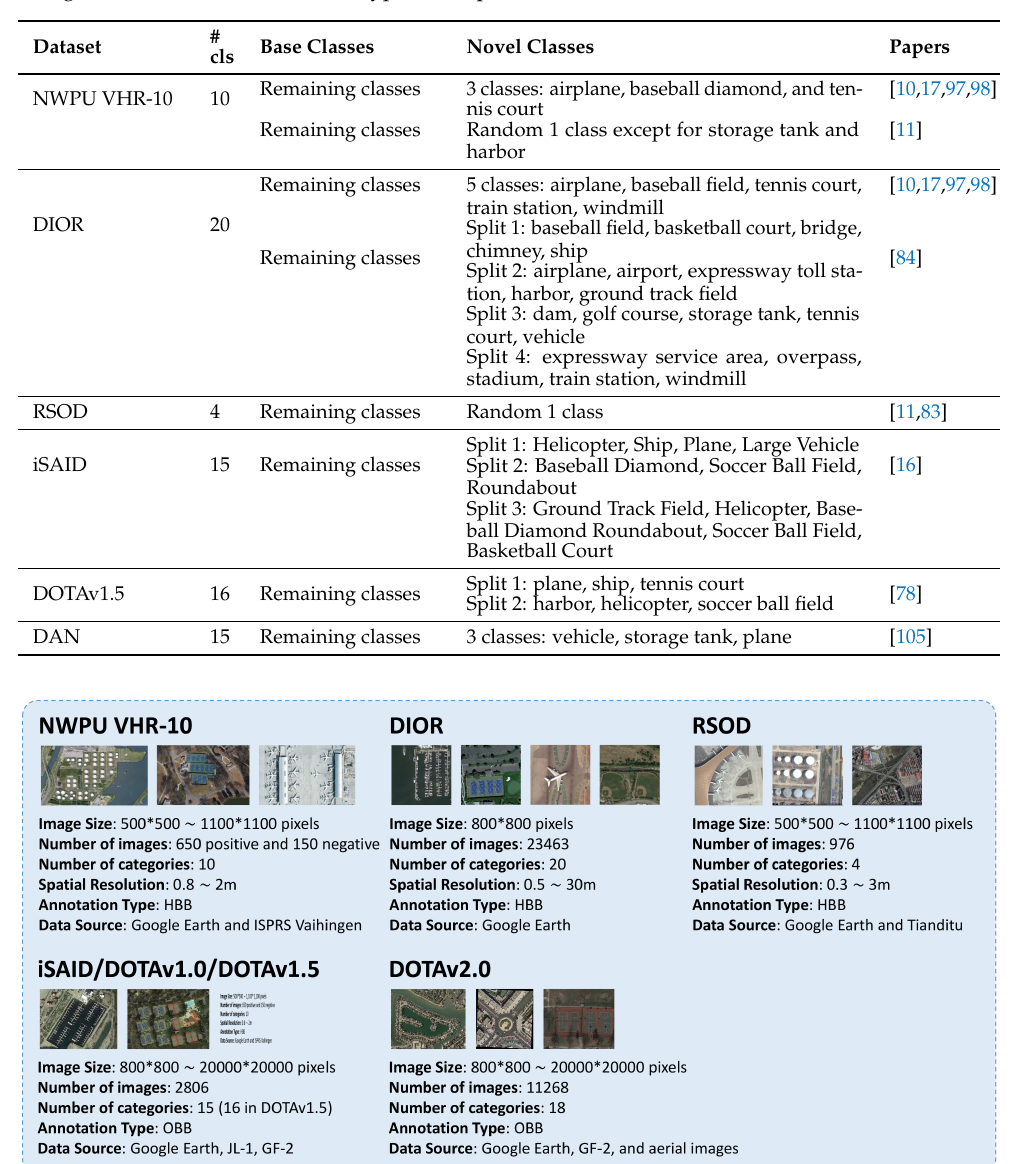
Table 1. Dataset selection and partitioning for FSOD algorithms on remote sensing images. DOTA and HRSC2016 are OBB annotated datasets but here they are converted to HBB. HRSC2016 is a fine-grained dataset with different types of ships.